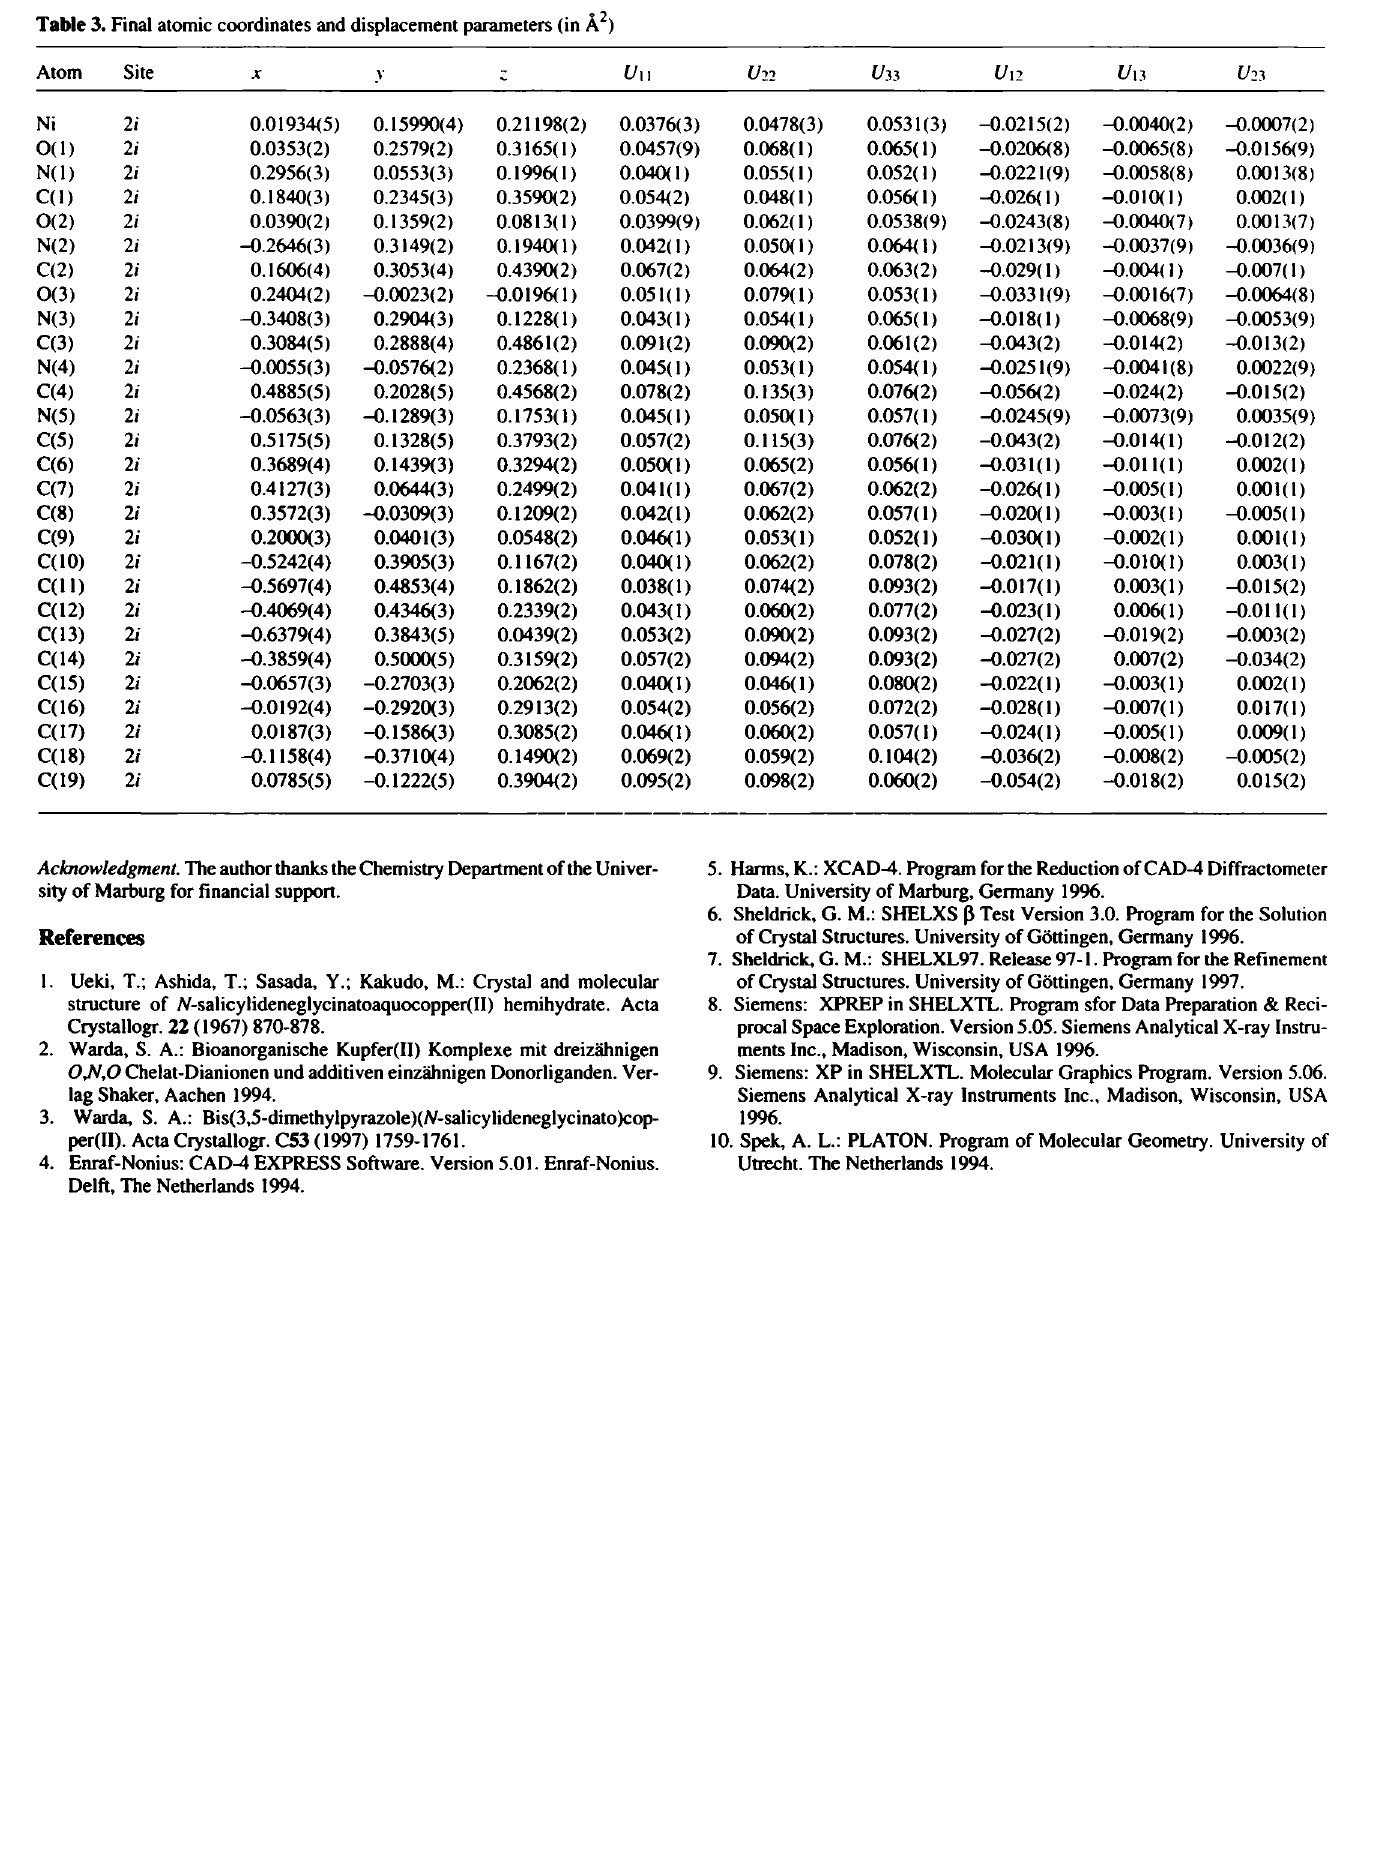
Table 3. Final atomic coordinates and displacement parameters (in